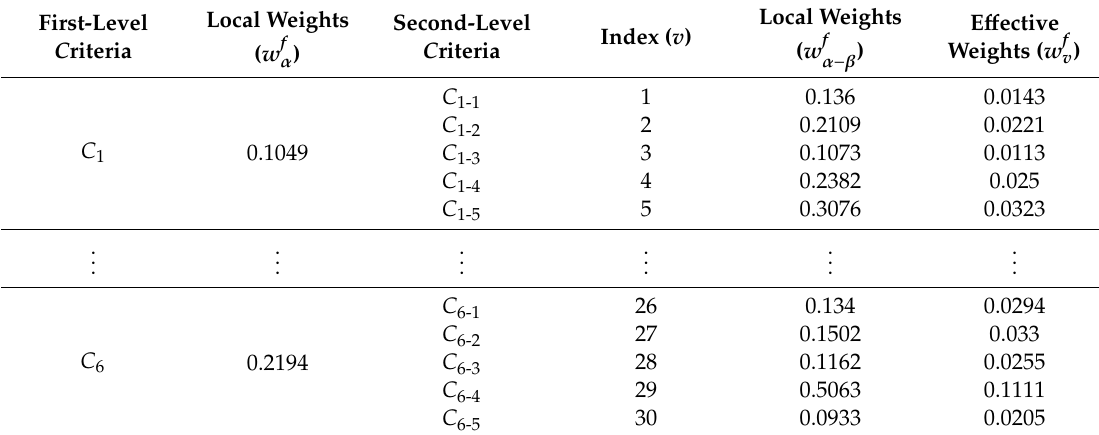
Table 6. Overall weights using the FUCOM